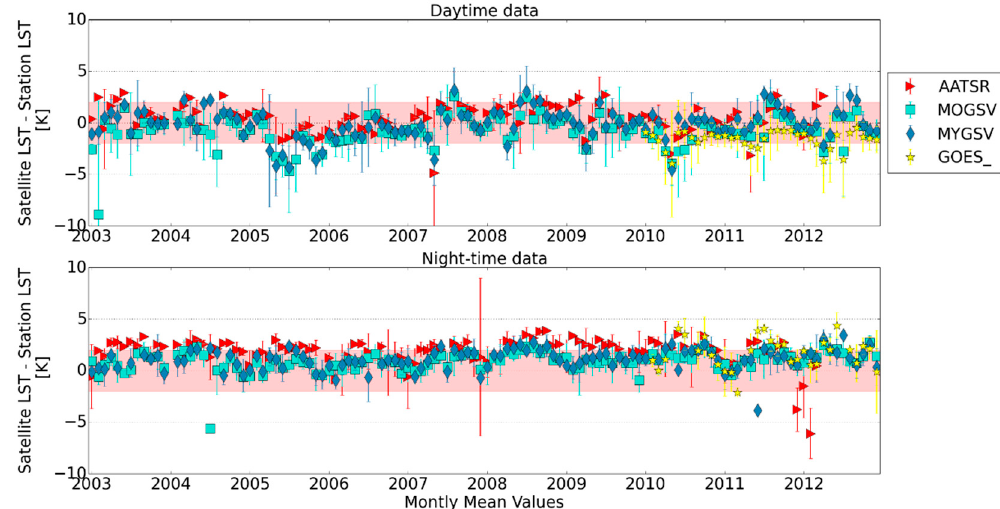
Figure 15. Monthly median accuracies (satellite LST–station LST) over GCM station for the years 2003–2012. The upper plot shows daytime and the lower night-time data. The ranges shaded in red indicate the ±2.0 K accuracy range.